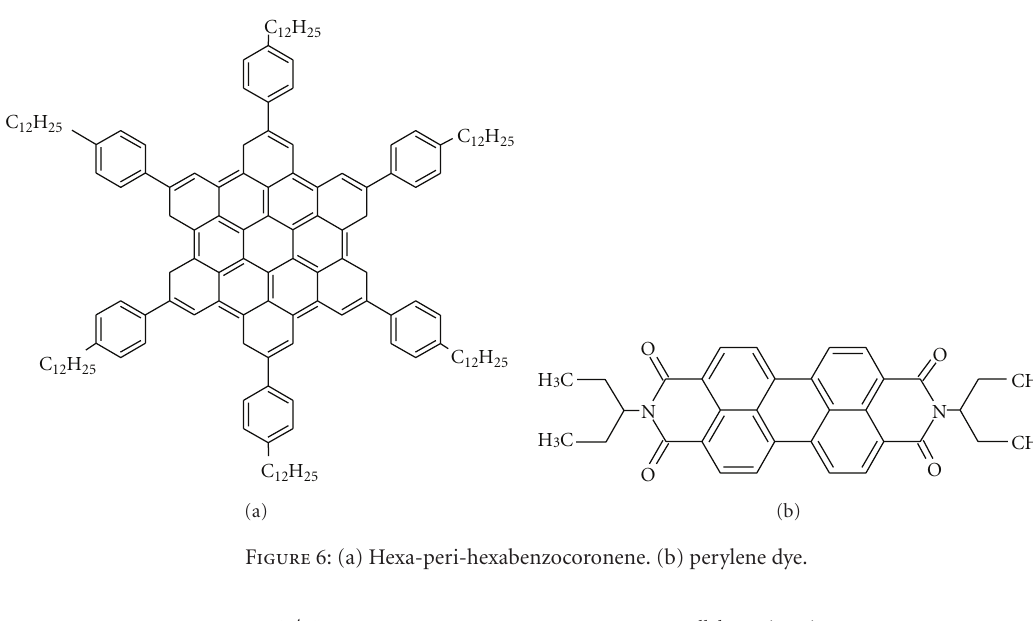
Figure 6: (a) Hexa-peri-hexabenzocoronene. (b) perylene dye.